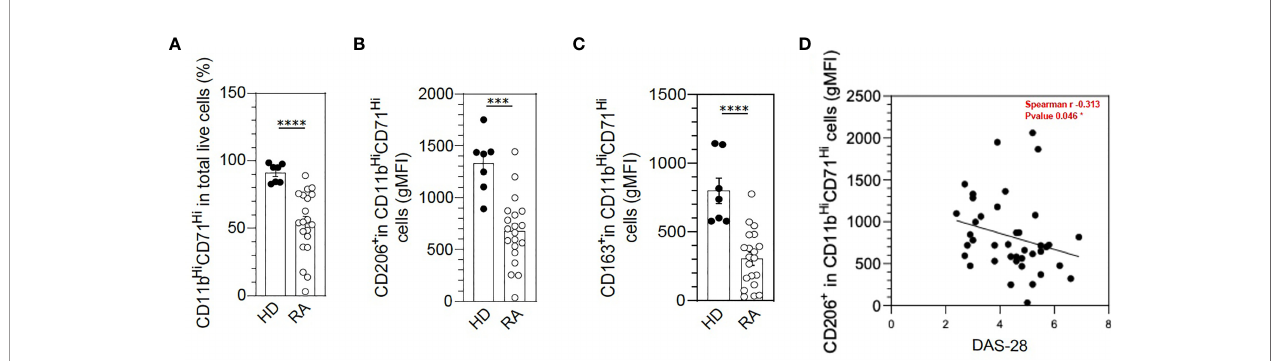
FIGURE 1 | M2-like macrophage polarization defect in rheumatoid arthritis (RA) monocytes under serum AB differentiation. The differentiation of frozen peripheral blood mononuclear cells (PBMCs) to M2-like macrophages was assessed in healthy donors (HDs) (n = 7) and RA patients (n = 20) by fl ow cytometry with anti- CD11b and anti-CD71 antibodies (A) . Speci fi c markers of M2-like macrophage polarization were assessed: CD206 (B) and CD163 (C) . Spearman ’ s correlation analysis of macrophage CD206 expression in RA patients (geometric mean [gMFI]) and disease activity (Disease Activity Score in 28 joints [DAS28]) (D) . Data are shown as symbols and mean ± SEM and were compared by Mann – Whitney t-test. *** p < 0.001 and **** p < 0.0001.